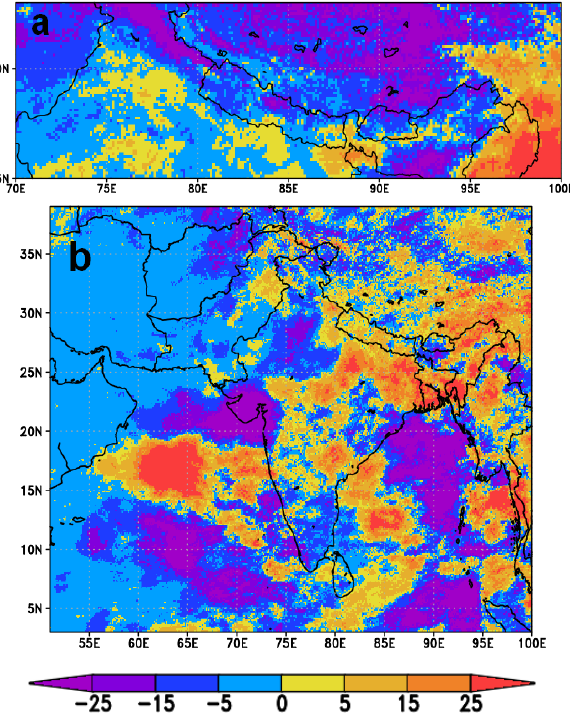
Figure 9. Difference in frequency of occurrence of convection per month for 2004 (high absorbing aerosol year) minus 2005 (low- aerosol year) for (a) a detailed view of the Himalaya foothills region in May and (b) India and surrounding waters in